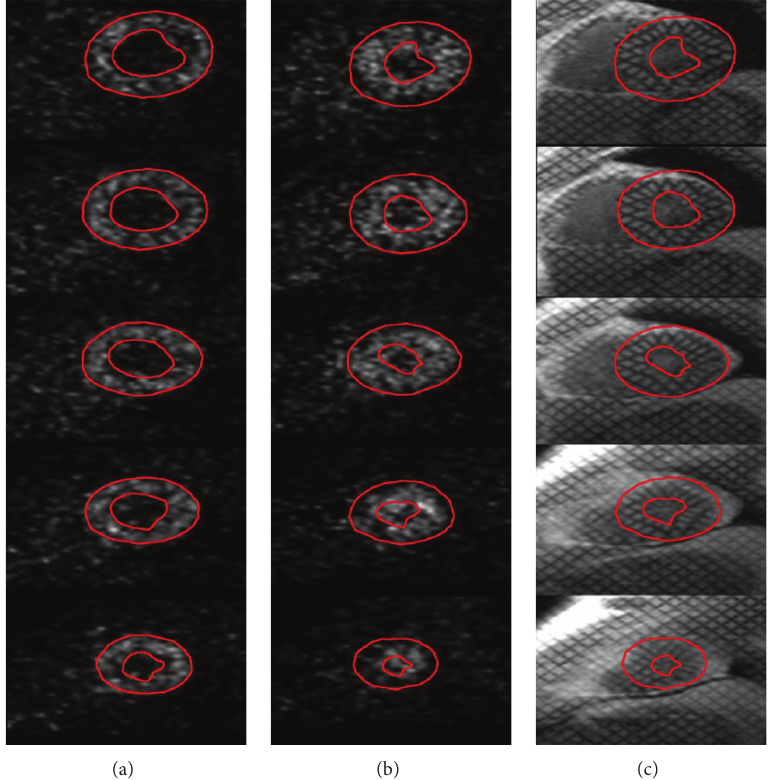
Figure 5: Registration comparison Heart 2. Warping analysis of Heart 2 also shows that excellent registration was achieved on this data set. (a) End-diastolic images used in the warping analysis, (b) the end-systolic PET images, and (c) the corresponding end-systolic tagged MRI images.